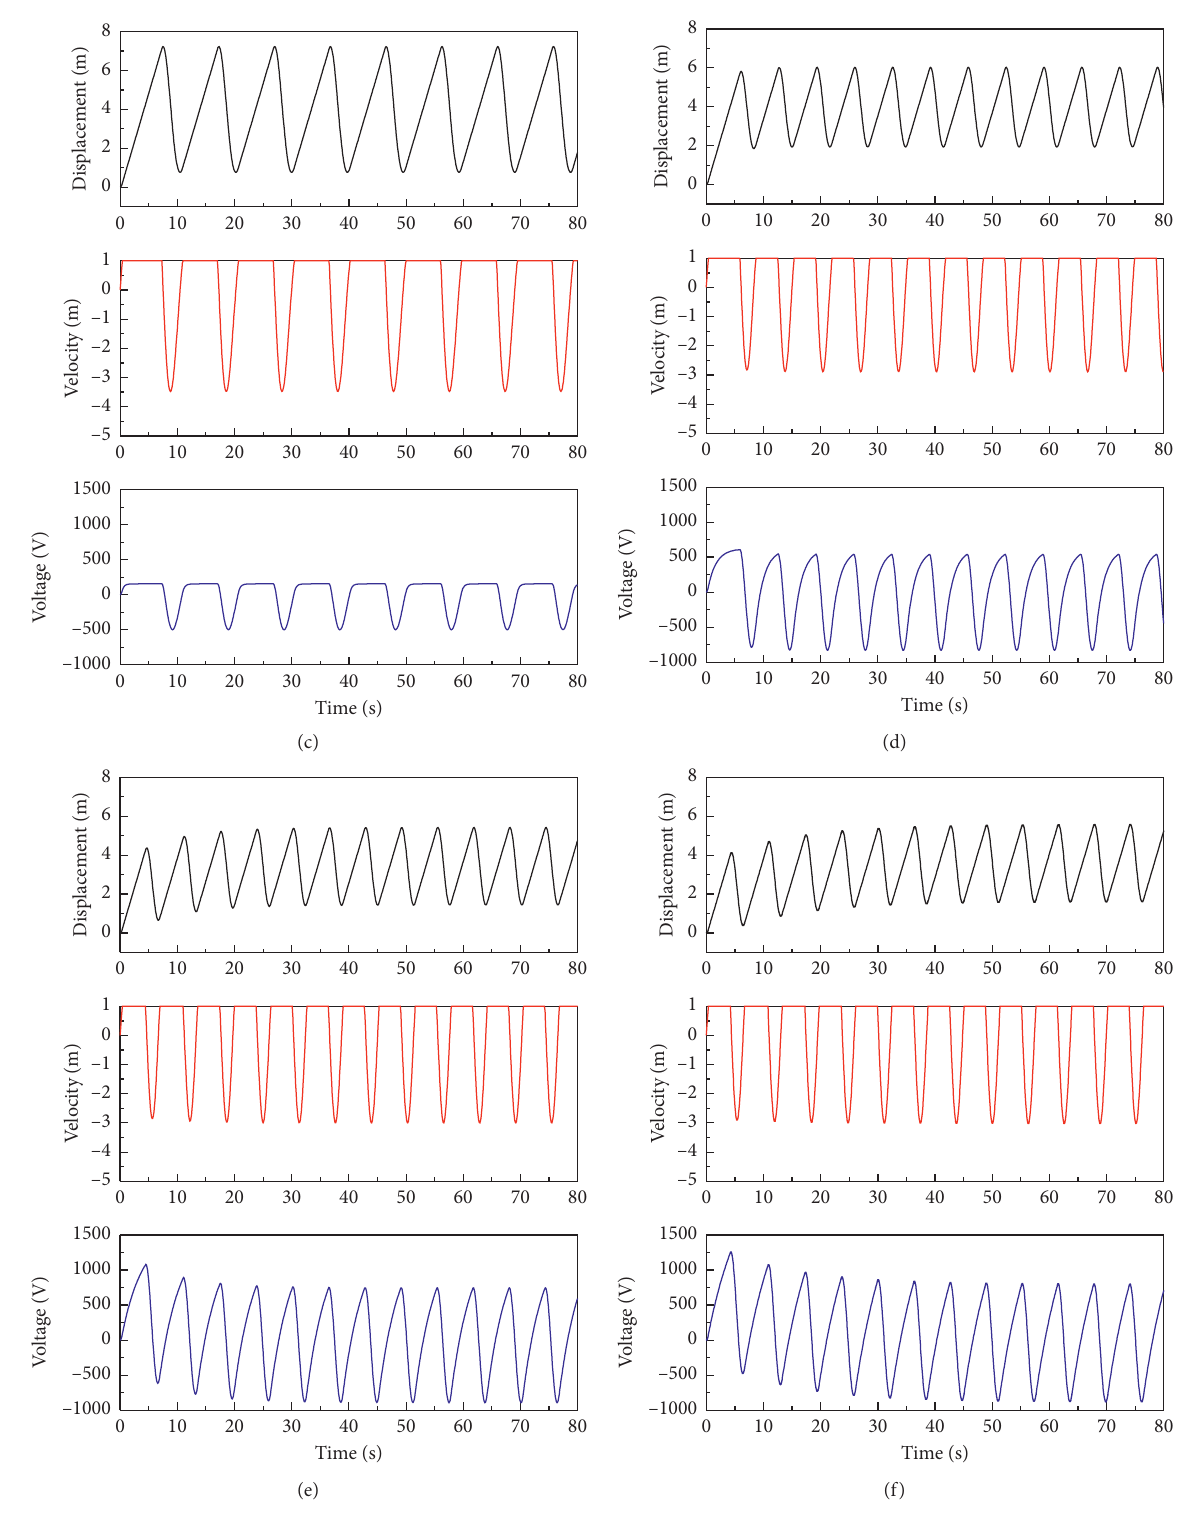
Figure 12: The dynamics and voltage signals of the friction system with different external electric resistance R in a large α . (friction law I): (a) R � 50000 Ω , (b) R � 10000 Ω , (c) R � 50000 Ω , (d) R � 200000 Ω , (e) 500000 Ω , and (f) R � 800000 Ω